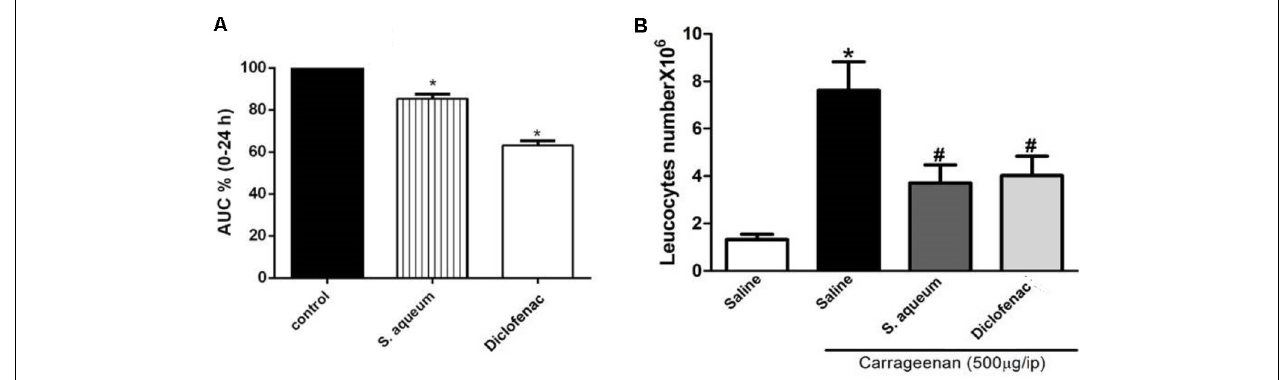
FIGURE 6 | Anti-inflammatory activities of S. aqueum leaf extract. (A) Effect of 1 h prior administration of S. aqueum (300 mg/kg, p.o.) or diclofenac (10 mg/kg, p.o.) on carrageenan (1% suspension, 0.1 ml/rat) induced-hind paw edema in rats. Edema thickness (mm) was measured before and then hourly for 6 h and at 24 h after carrageenan injection. Data represents the AUC 0 - 24 and are expressed as mean ± SEM ( n = 5–7). (B) Effect of carrageenan (500 µ g, i.p.) on leukocytes migration into the peritoneal cavity (total number × 10 6 ) with or without 1 h prior treatment with the extract (300 mg/kg, p.o.) or diclofenac (10 mg/kg, p.o.). Data are expressed as mean. ± SEM ( n = 5–7). ∗ p < 0.01 vs. control values; # p < 0.05 vs. carrageenan.